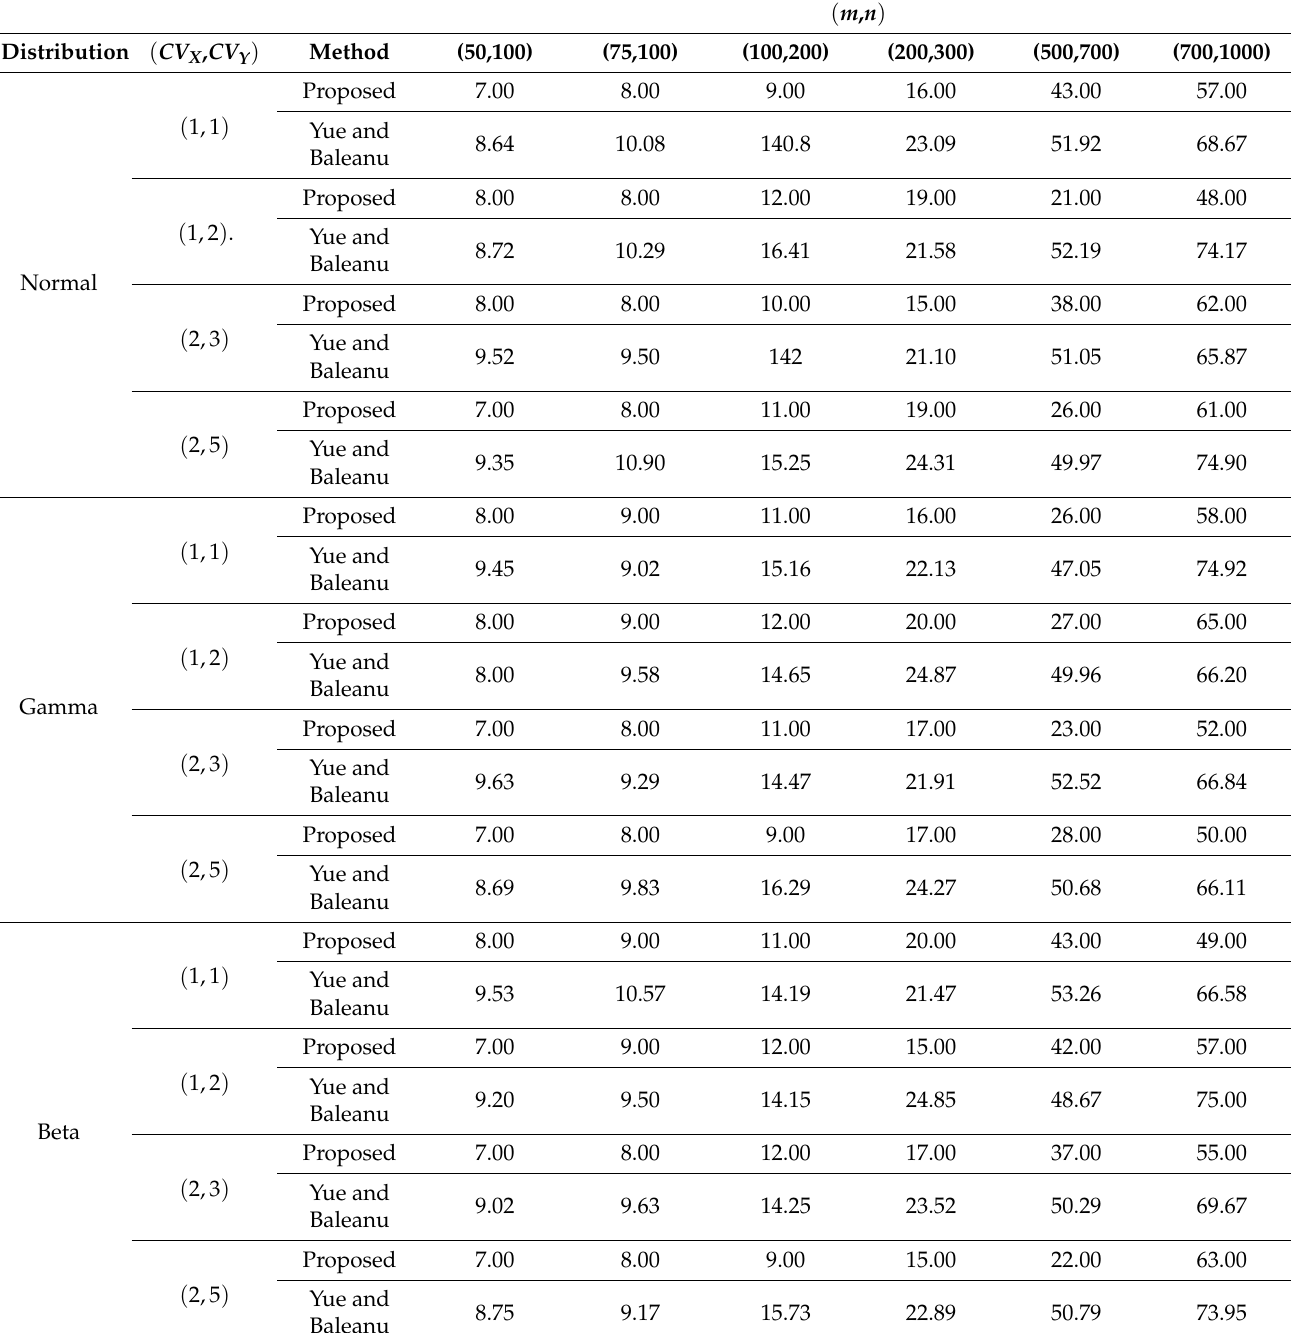
Table 3. The CPU time needed for running the proposed and the Yue and Baleanu [27] methods, for various settings of